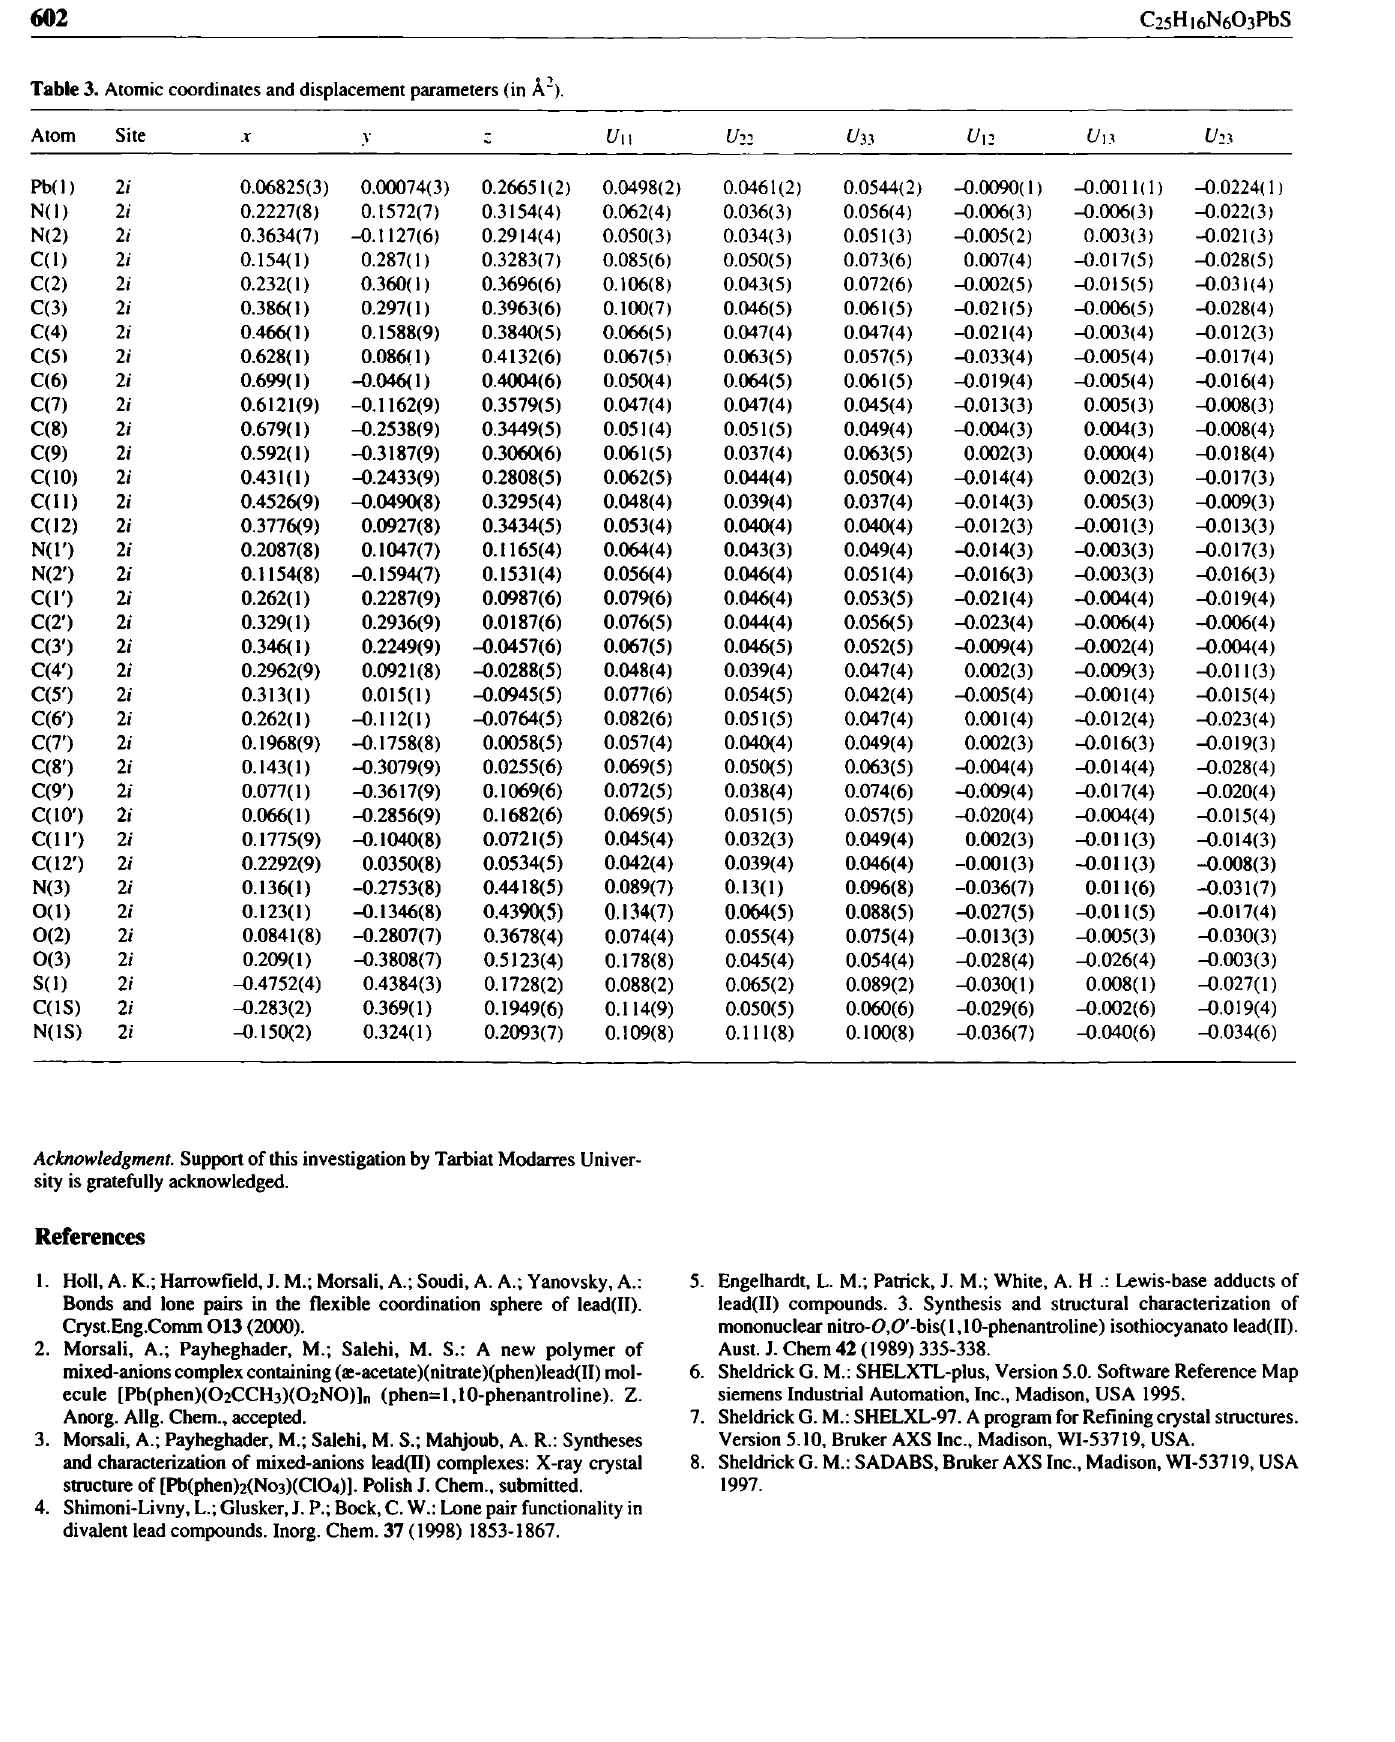
Table 3. Atomic coordinates and displacement parameters (in